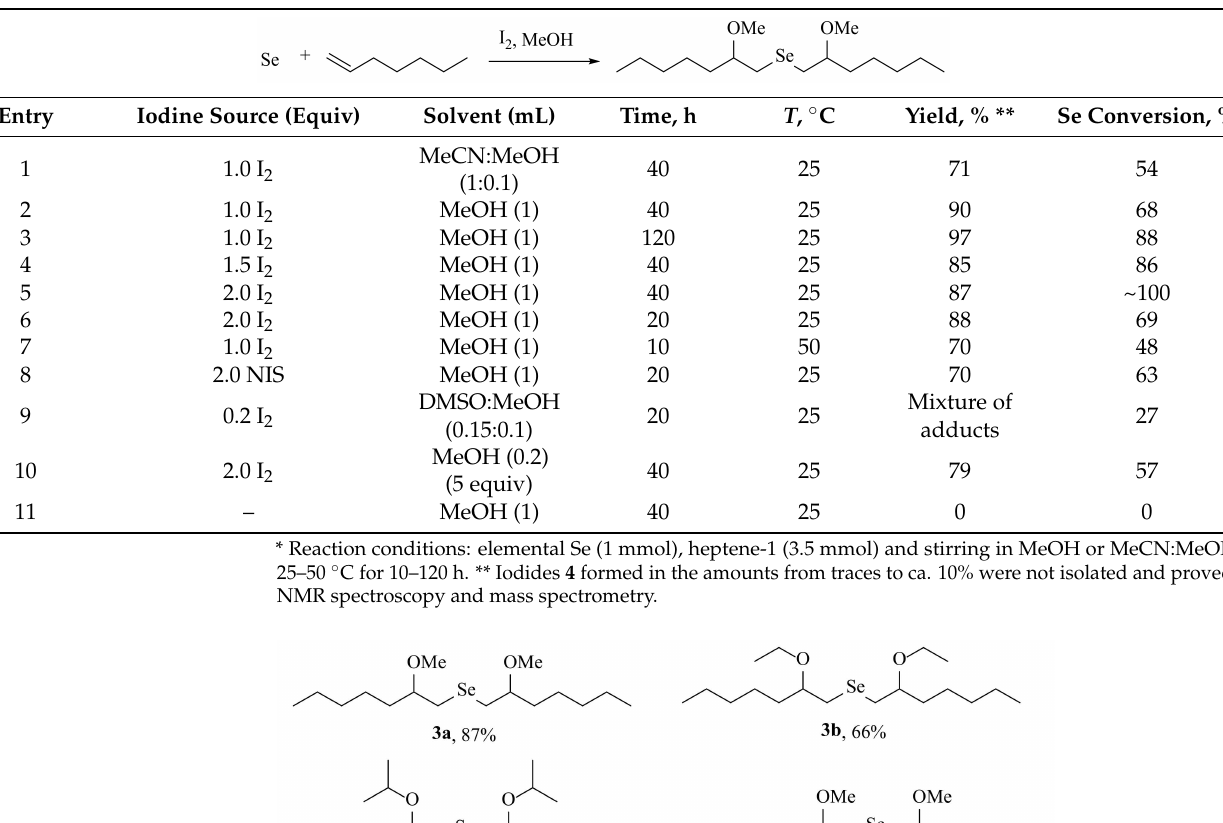
Table 1. Optimization of reaction conditions *.